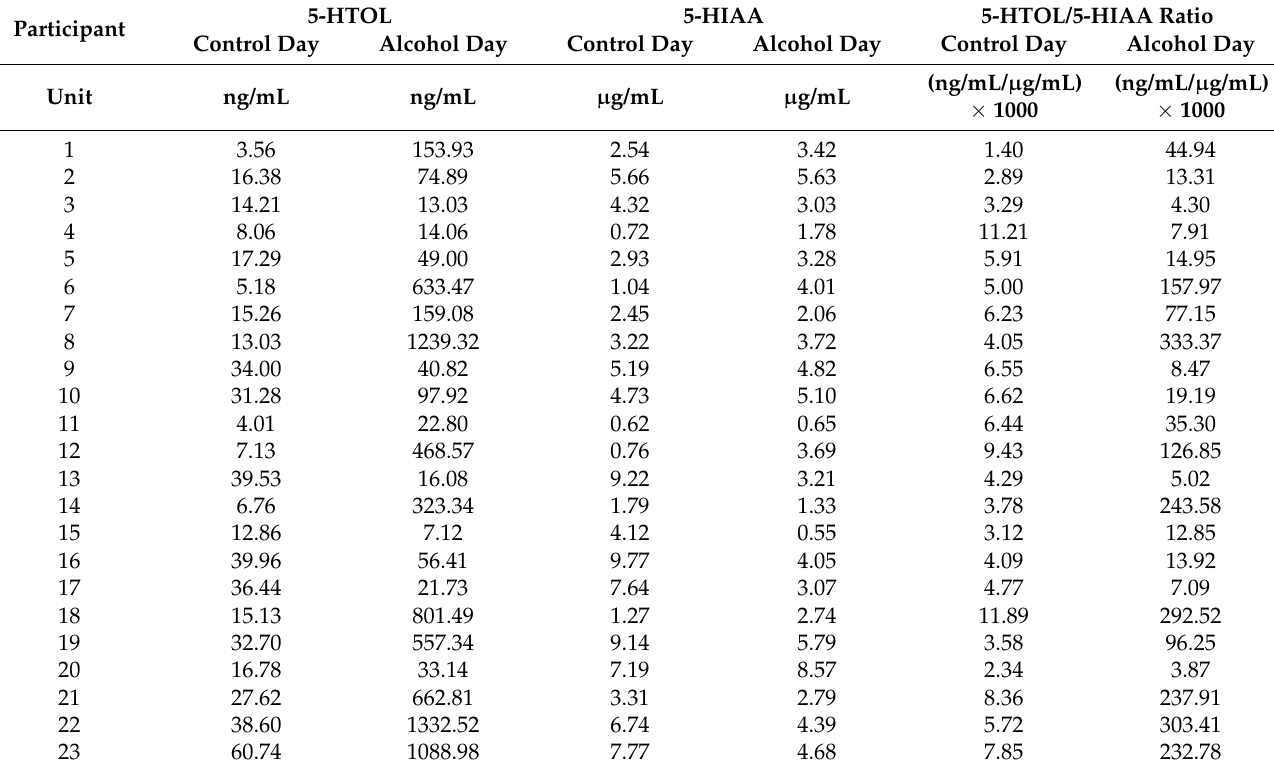
Table A3. Biomarker assessments—individual participant